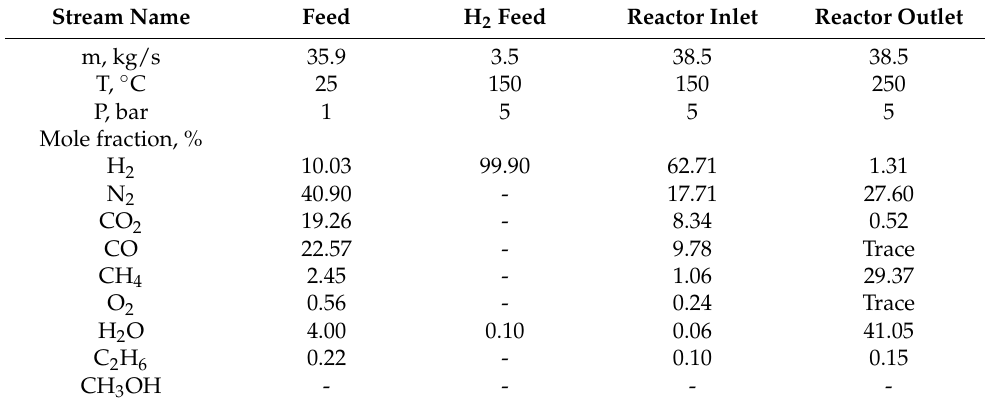
Table A1. Stream results of the NG case.